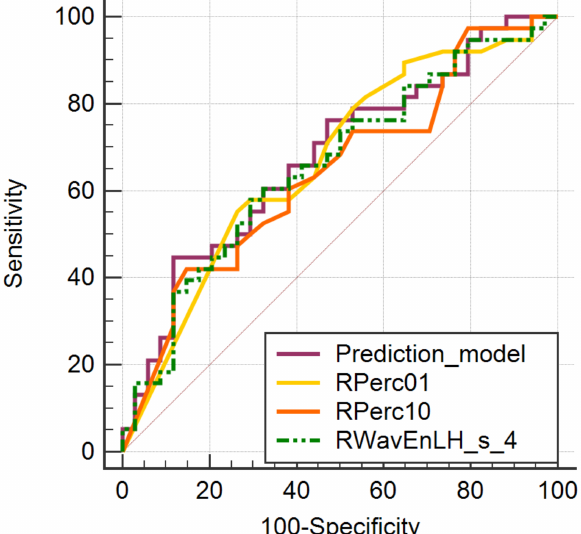
Figure 4. ROC curves of the parameters that showed statistically significant results in the comparison of PR+ and the PR − patients (RPerc01, RPerc10 and RWavEnLH_s_4) and of the prediction model that incorporated the three